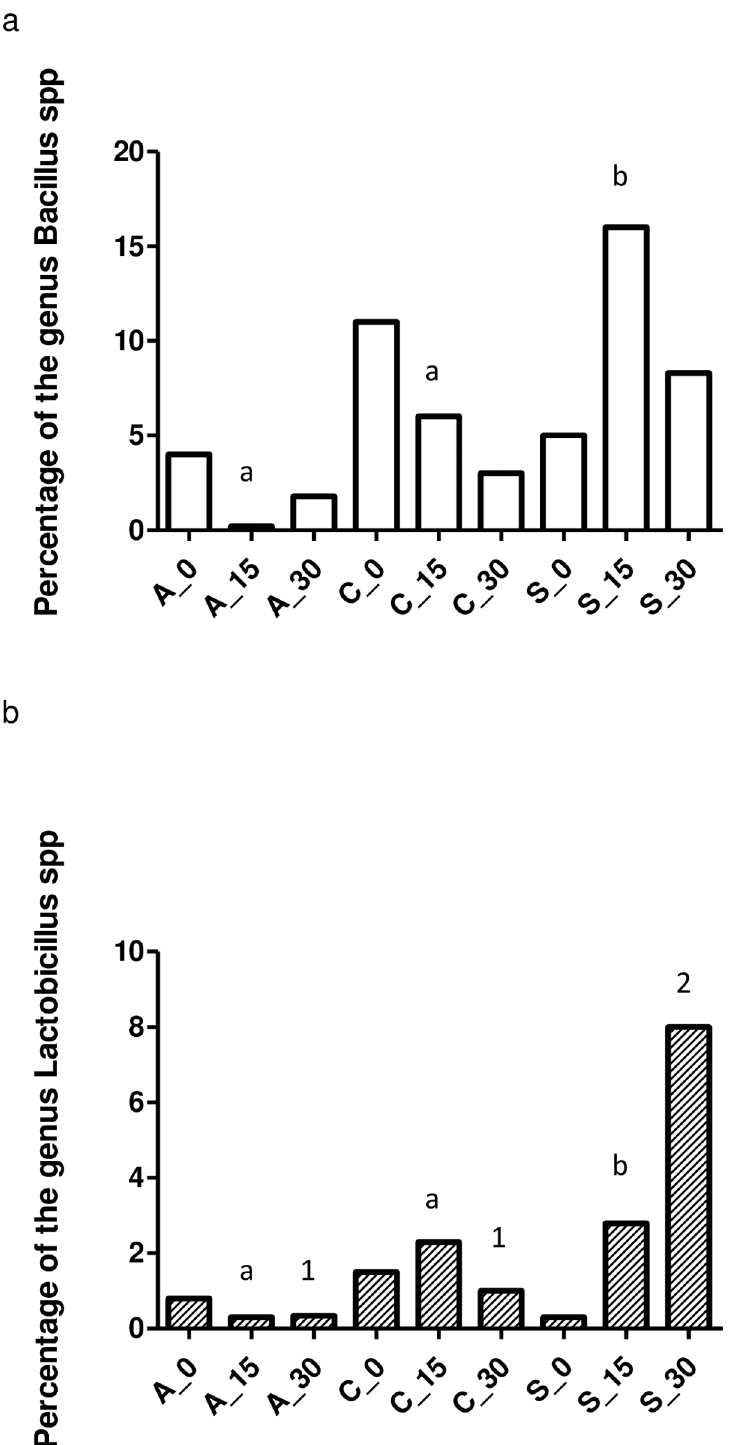
Fig 7. Percentage of the genus Bacillus (a) and Lactobacillus (b) spp grouped based on the treatment applied at day 0, 15 and 30 post-beginning the trial. X_Y means experimental (control-C, feed additive- S, antibiotic-A,) and day group (0, 15 and 30), respectively. The statistical differences are shown between groups inside each sampling time. Different letters and numbers means statistical significant differences for 15 and 30 days of the trial, respectively (p < 0.05).